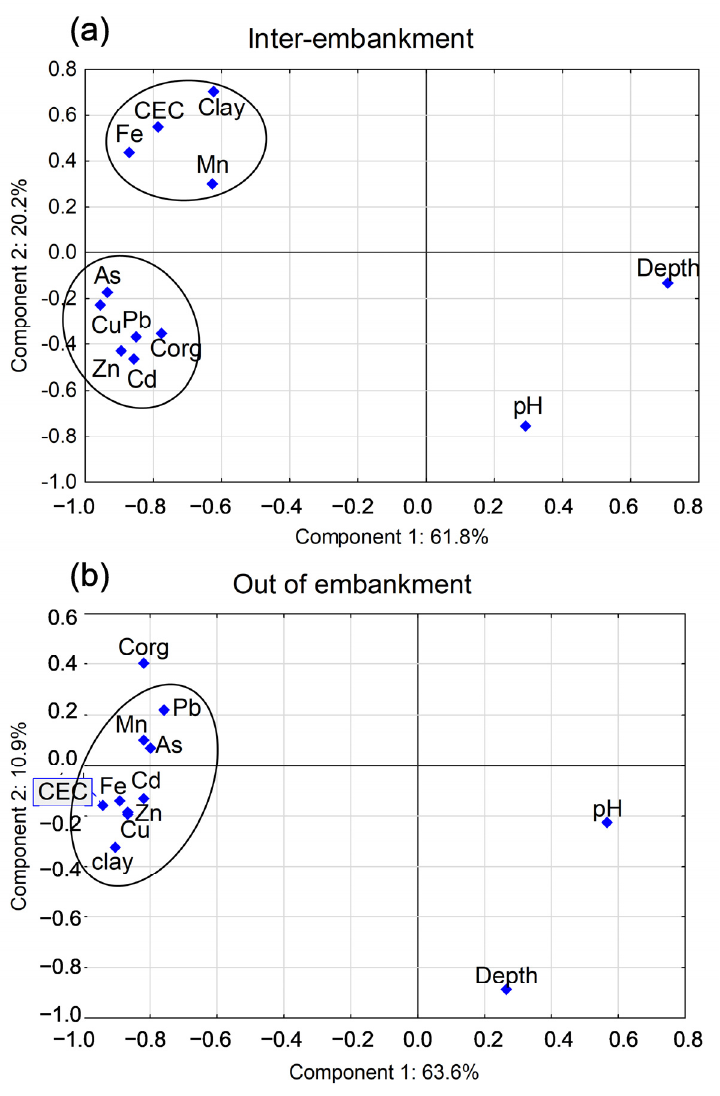
Figure 5. The results of PCA analysis carried out for: ( a ) inter-embankment (above) and ( b ) out-of-embankment (below) soil samples, separately.